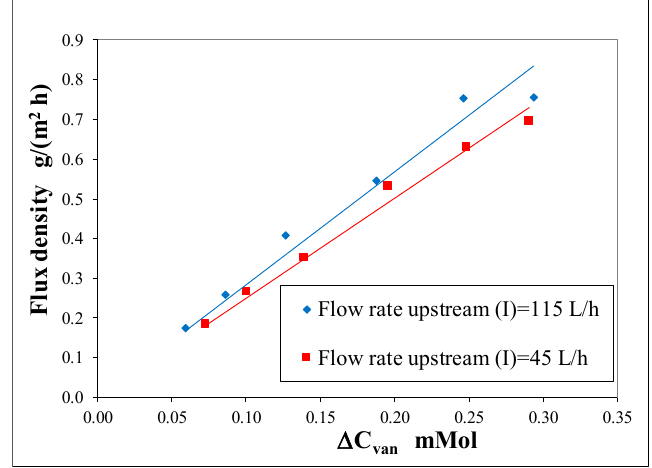
Figure 4. Flux density of vanillin vs. the driving force Δ C van . T =60 °C, pH ≈ 5.5, and downstream flow rate of Liquid 2 through the module = 75 L/h (Re 2 = 1020).